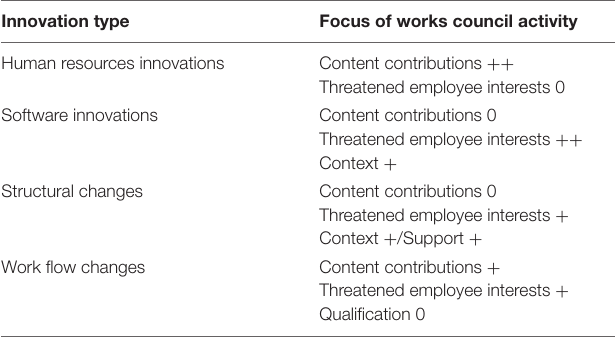
TABLE 2 | Works council participation in different types of